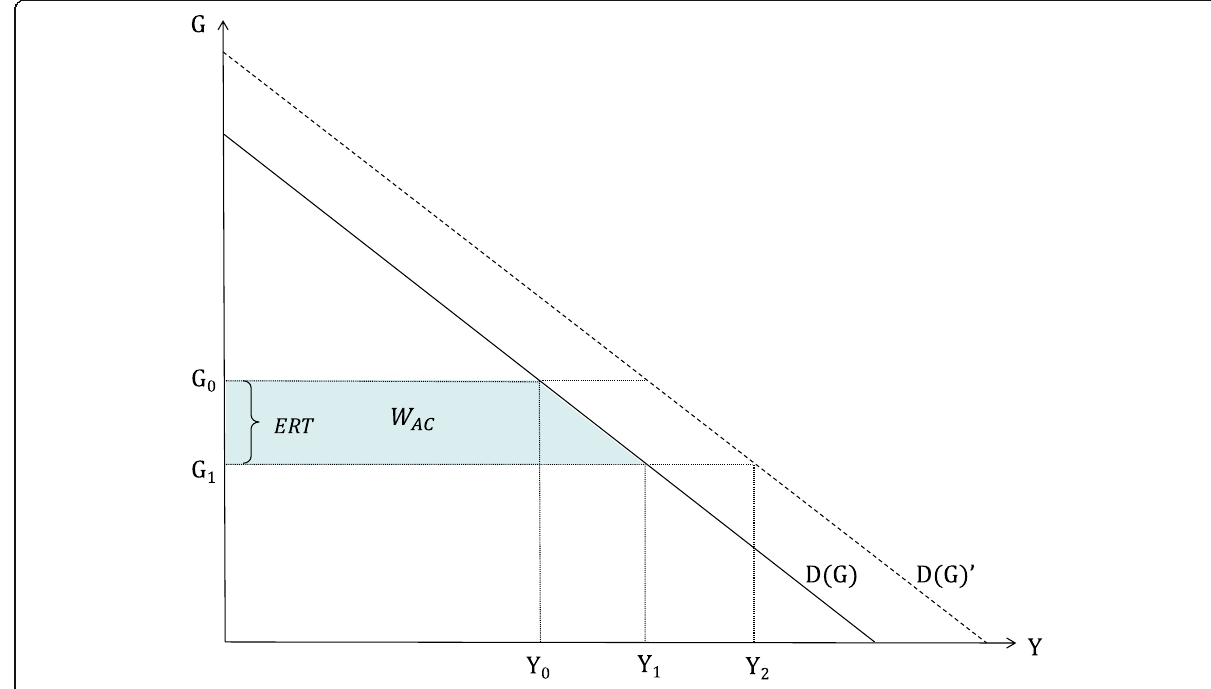
Fig. 3 Welfare changes for travellers between place A and place C by introducing a request stop instead of a fixed stop at place